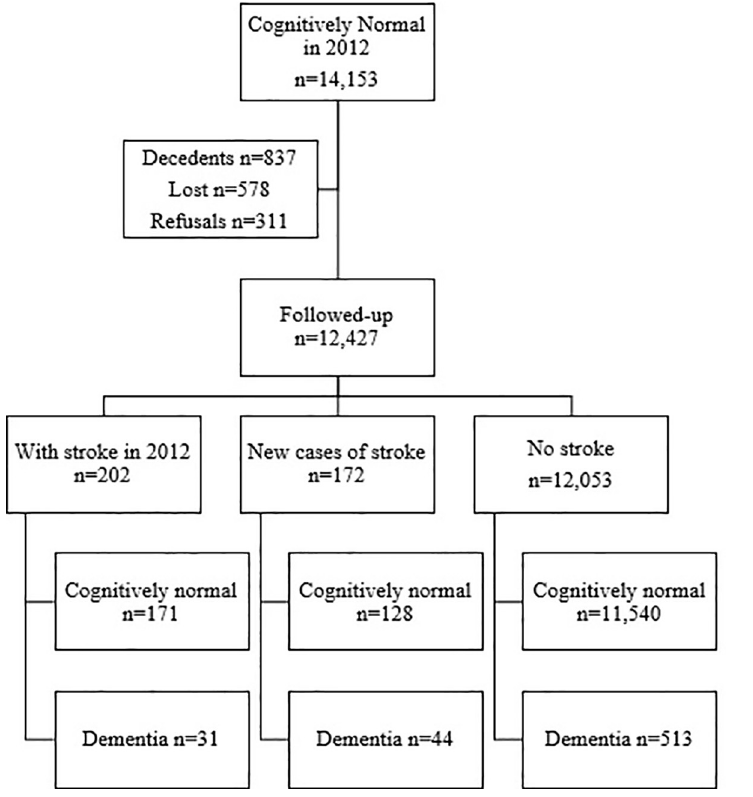
Fig 2. Flowchart of sample selection at follow-up (MHAS